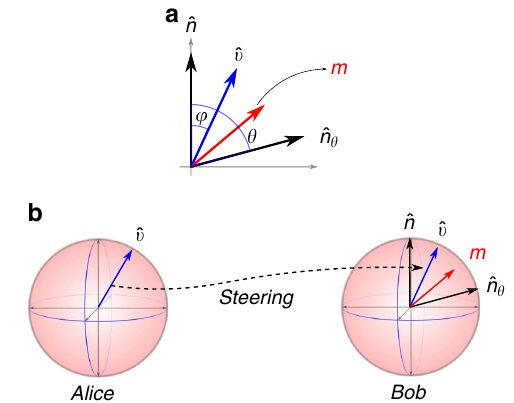
Fig. 2 The Bloch sphere representation of the measurement situation. a The state ψ j i of the polarized photon is represented by ^ v , while the projectors Q (0) and Q ( θ ) correspond to unit vectors ^ n and ^ n θ , respectively, and m is give by m = 1 (cid:4) p ð Þ ^ n þ p ^ n θ . The bound on the probability of transmission ξ ( θ , p ) is obtained from the vector m , ξ ( θ , p ) = 1 þ m j j . The uncertainty relation 2 de fi ned by the probability of transmission ( P (transmission) ≤ ξ ( θ , p ) < 1)